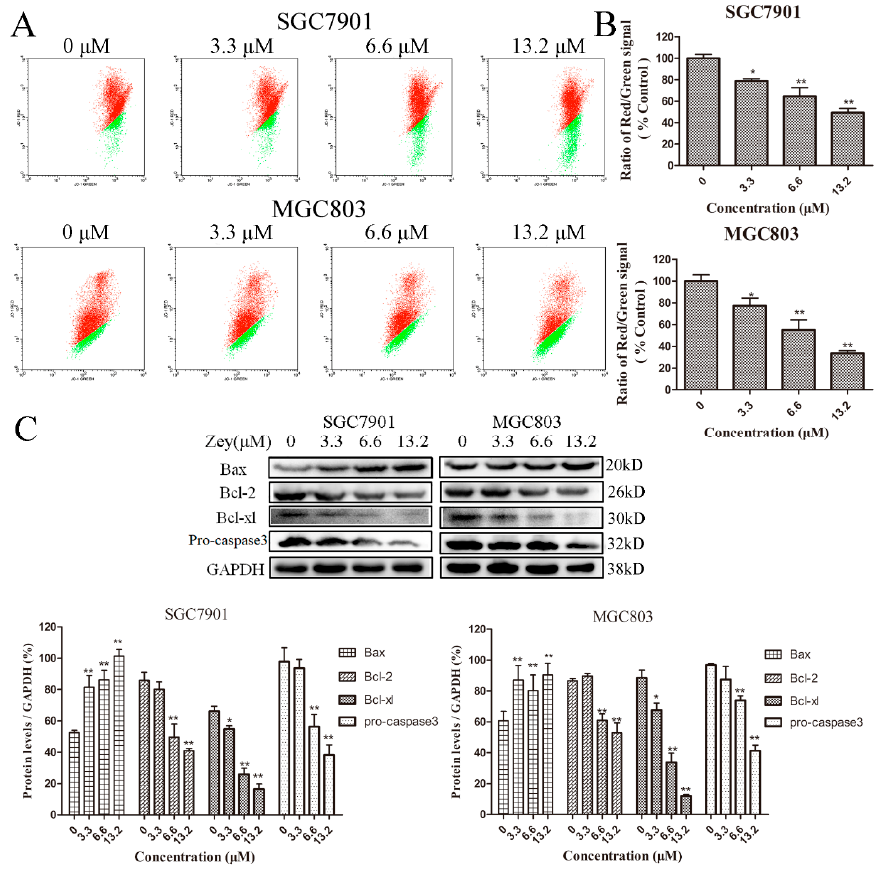
Figure 3. Zey induces apoptosis of SGC7901 and MGC803 cells through the initiation of the mitochondrial pathway. ( A ) Zey induced a loss of mitochondrial membrane potential in SGC7901 and MGC803 cells. Cells were treated with increasing concentrations of Zey for 24 h, and mitochondrial membrane potential was analyzed by flow cytometry after cells were stained with JC ‐ 1. ( B ) Quantitative analysis of the ratio of red to green fluorescence. The data represented the means ± SD for triplicate determinations. * p < 0.05 and ** p < 0.01 vs. control cells. ( C ) Apoptosis ‐ related protein expression was detected by Western blot analysis in SGC7901 and MGC803 cells. Cells were incubated with Zey (0, 3.3, 6.6, or 13.2 μ M) for 24 h, and whole ‐ cell lysates were analyzed. The data represented the means ± SD for triplicate determinations. * p < 0.05 and ** p < 0.01 vs. control cells.